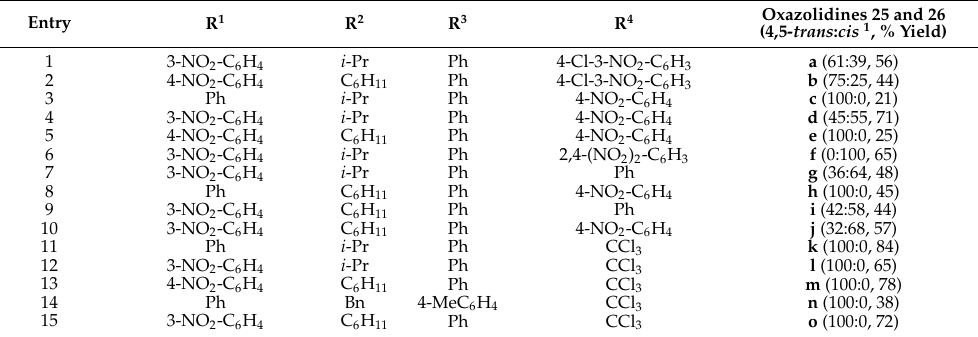
Table 2. Cycloaddition of trans -azomethine ylide 24 to aldehydes 2 (Scheme 4). Entry R 1 R 2 R 3 R 4 Oxazolidines 25 and 26 (4,5- trans : cis 1 , % Yield)